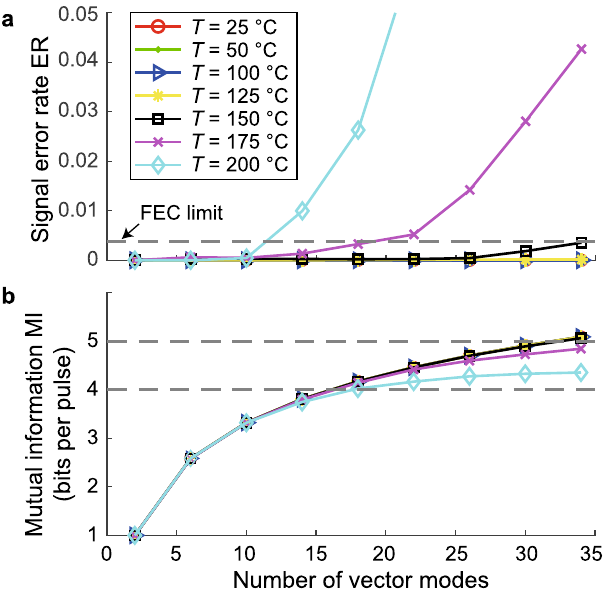
Fig. 8 Experimentally obtained transmitted signal quality. The experimental ( a ) signal error rate and ( b ) mutual information as functions of the number of vector modes used in the system at various temperatures. The forward error correction (FEC) limit of 3.8 × 10 − 3 is plotted as a dashed line. Here, all levels are considered equally probable in the data